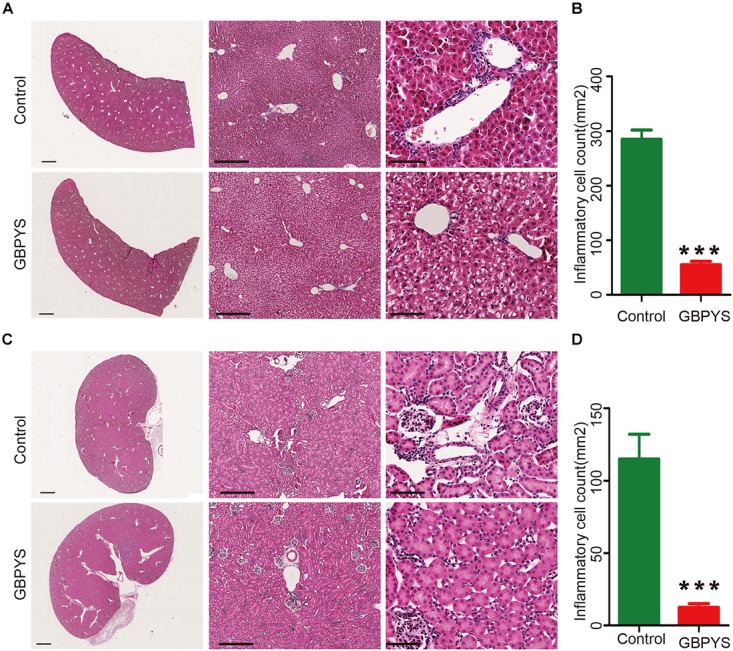
GBPYS feeding for 7 days alleviated inflammation of liver and kidney in mice with MI. (A) GBPYS feeding for 7 days reduced the accumulation of inflammatory cells around the hepatic junction in mice with MI compared with Ctrl MI mice fed with regular food (n = 6). (B) Quantification of inflammatory cells around the hepatic junction from six liver slides (P < 0.001). (C) GBPYS feeding for 7 days reduced the accumulation of inflammatory cells around the blood vessels of the kidney in mice with MI compared with control MI mice fed with regular food (n = 6). (D) Quantification of inflammatory cells around the blood vessels from six kidney slides. Scale bars, 2 mm, 200 μm, 50 μm, respectively. ∗∗∗P < 0.001.